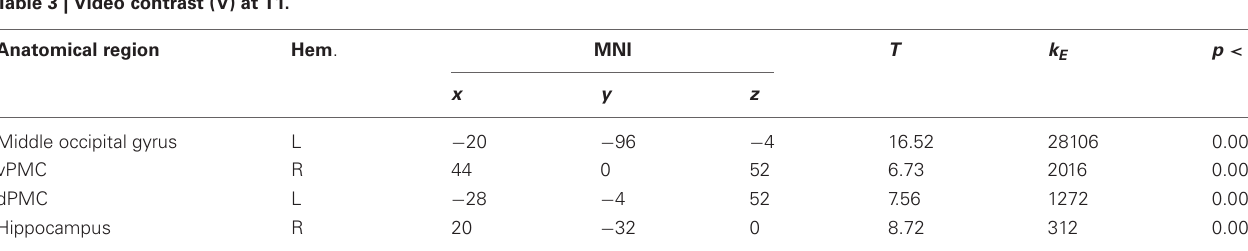
Table 3 | Video contrast (V) at T1.